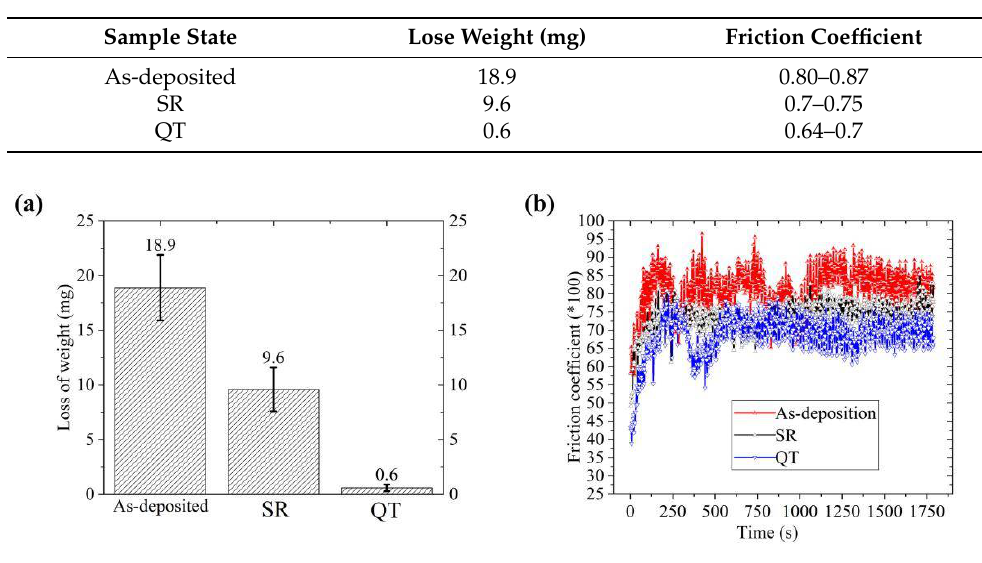
Figure 11. Weight and coefficient of friction at high-temperature: ( a ) the weight lost by friction; ( b ) friction